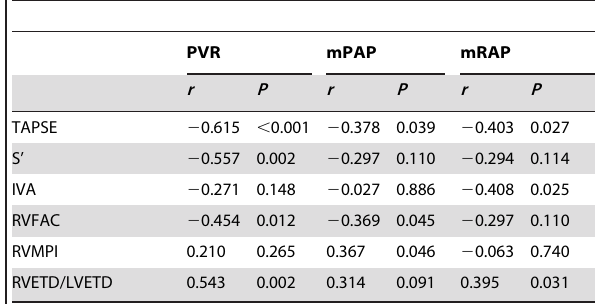
Table 2. Data of Echocardiography and Cardiac Magnetic Resonance.